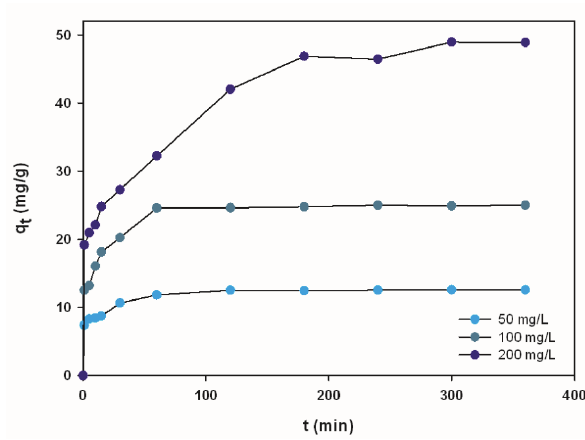
Figure 1: Adsorption capacity of CuPC on H. communis sponge skeleton, as a function of time (results obtained at